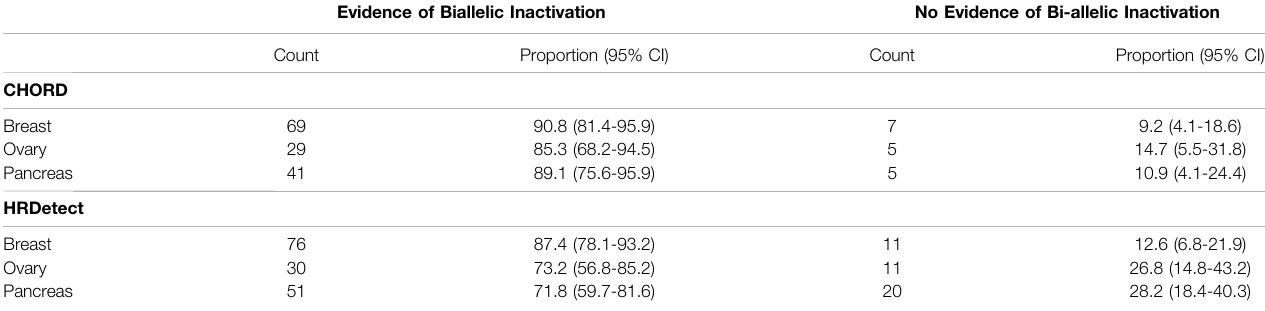
TABLE 1 | Summary of tumor samples classi fi ed to possess HRD by CHORD and HRDetect within an individual cancer type. Evidence of Biallelic Inactivation